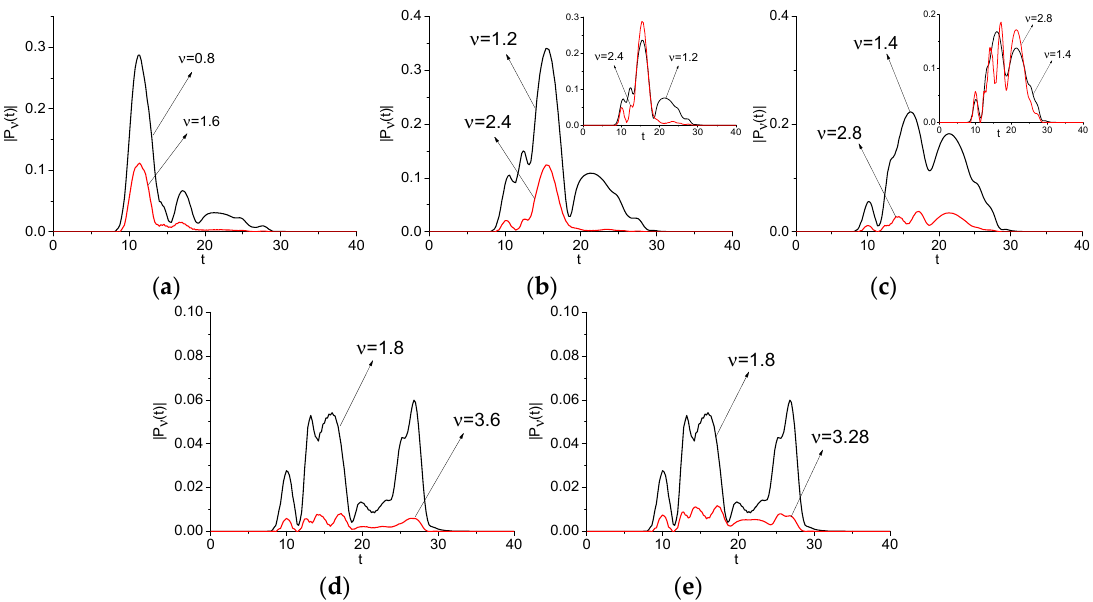
ν = 0.8, 1.2, 1.4, base